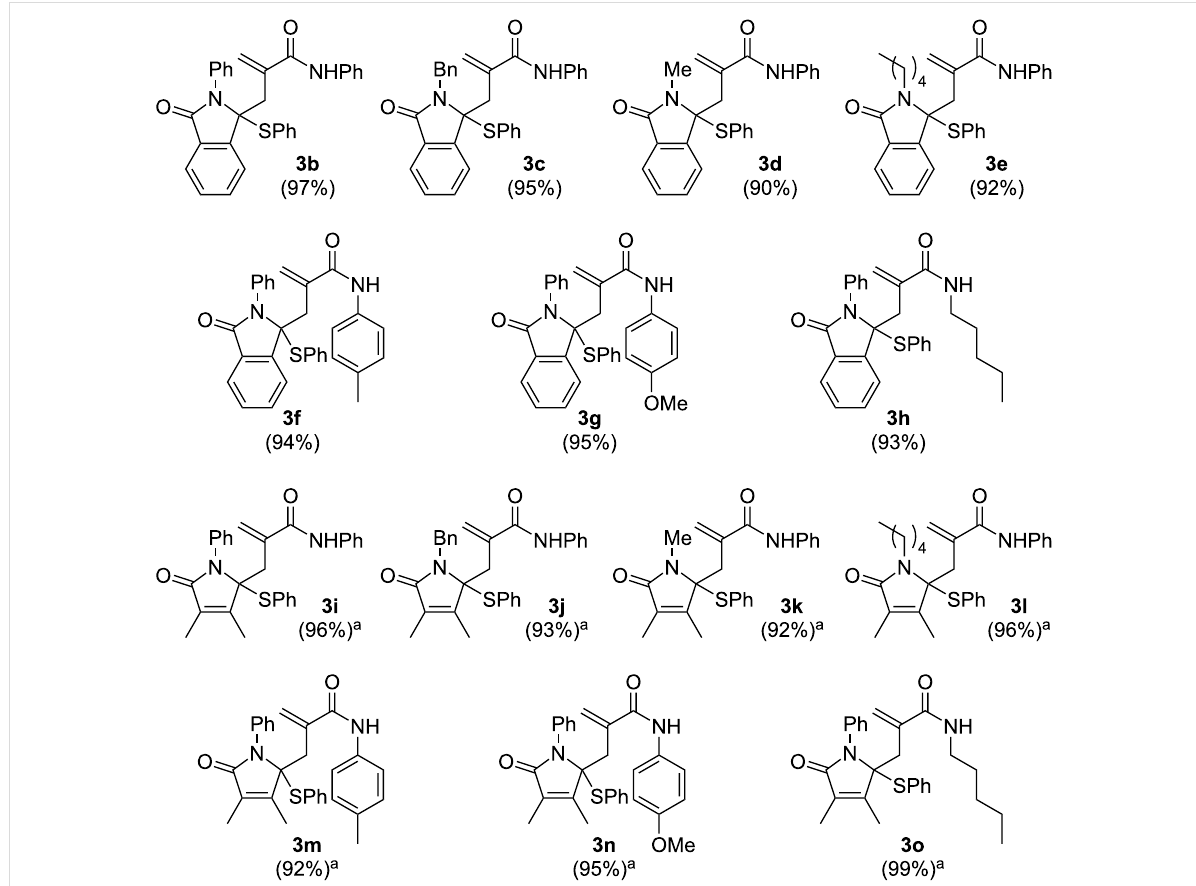
Figure 1: Syntheses of 3b – o via electrophilic amide allylation of γ -phenylthio lactams. Reactions were carried out with 1 (1.2 equiv), 2 (1.0 equiv), and NaH (2.5 equiv) in THF (0.2 M for 2 ) at − 10 °C for 1 h. a Reactions were performed at − 20